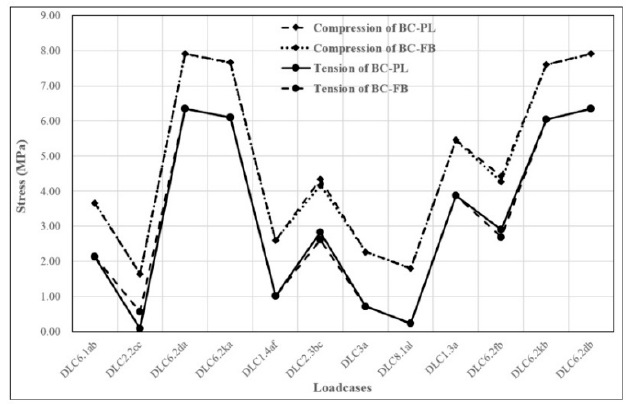
Figure 10. Comparison of stresses in concrete of BC-PL model and BC-FB model.